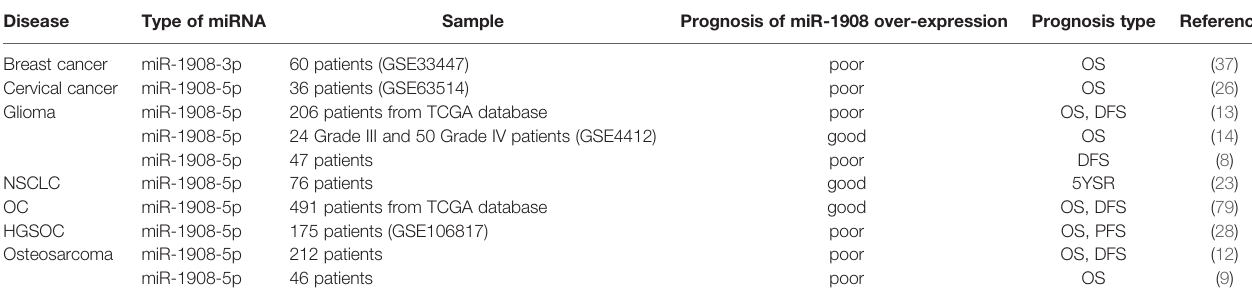
TABLE 4 | Prognostic value of miR-1908 in different